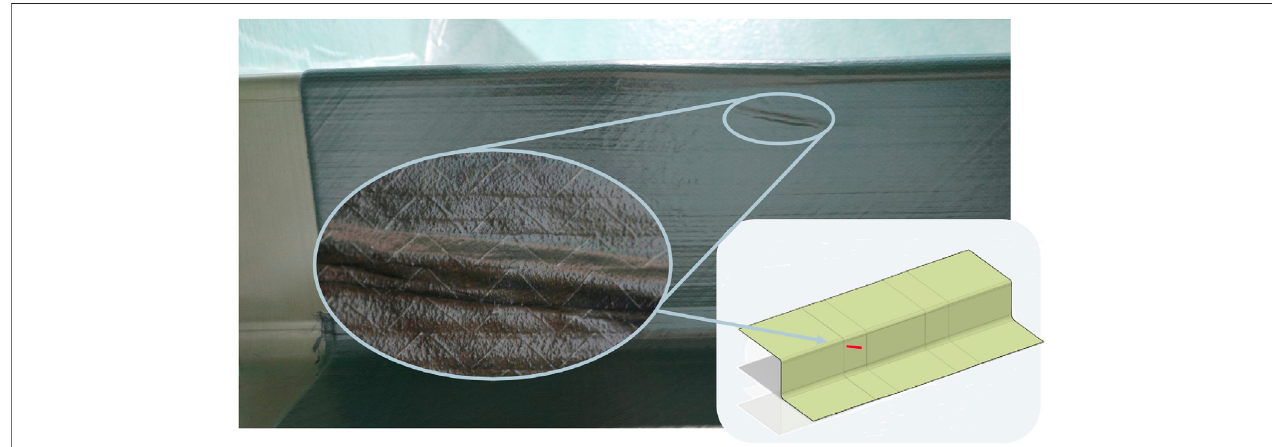
FIGURE 12 | Photograph of wrinkle observed during forming trial including (A) Close up photograph of wrinkle and (B) location marked on CAD geometry.